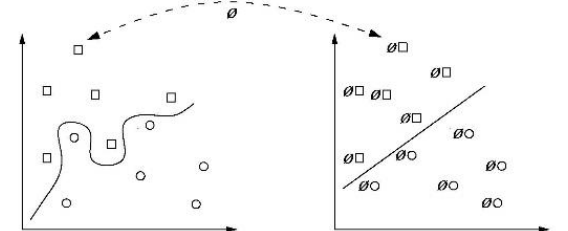
Figure 3. Use of kernel function to transform the original space into a space with different characteristics.